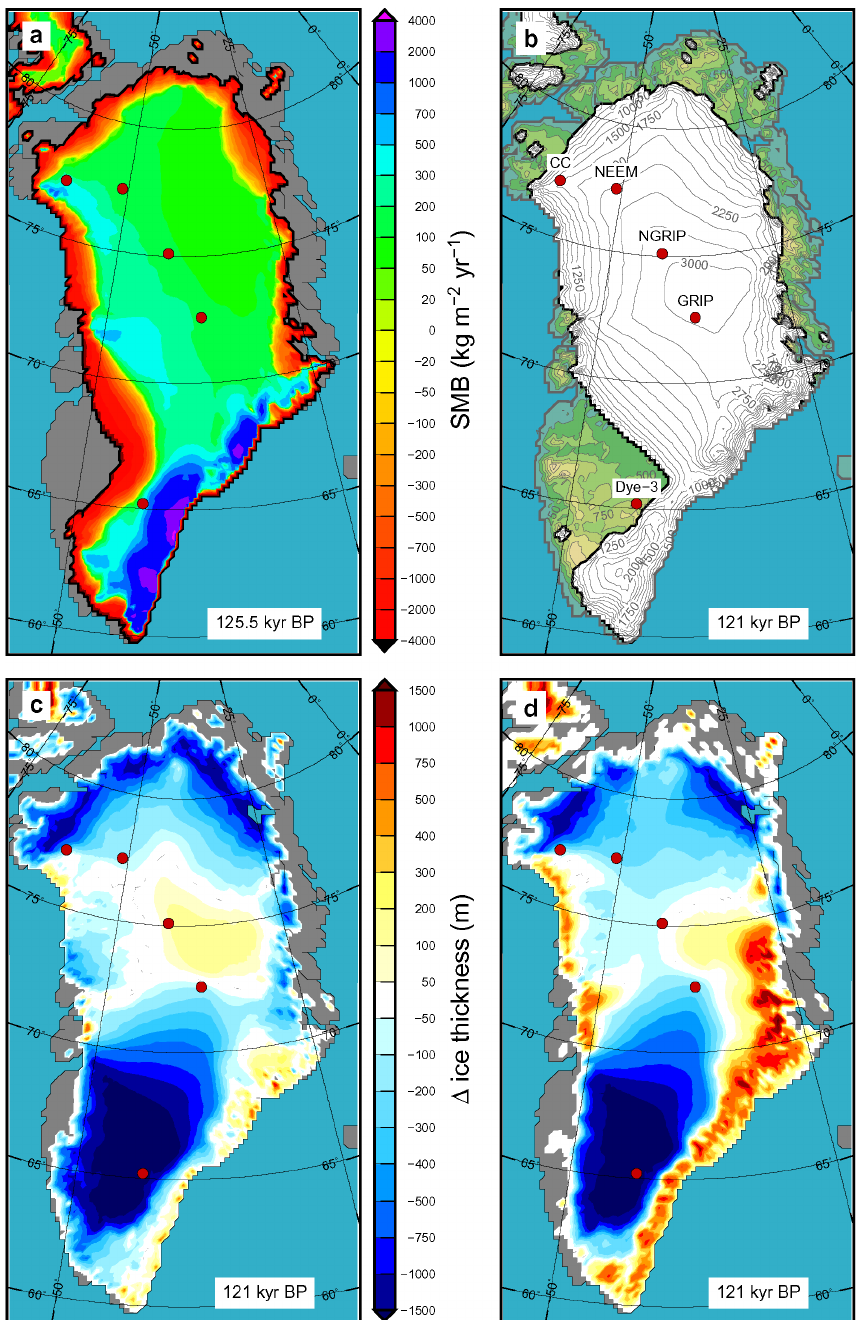
Fig. 6. SMB, minimum extent and ice thickness anomaly. (a) SMB pattern during Eemian optimum conditions, (b) simulated minimum GrIS at 121kyrBP, (c) difference in ice thickness compared to present-day simulation and (d) difference in ice thickness compared to present-day measurements. An animation of GrIS evolution from 130 to 115kyrBP is available